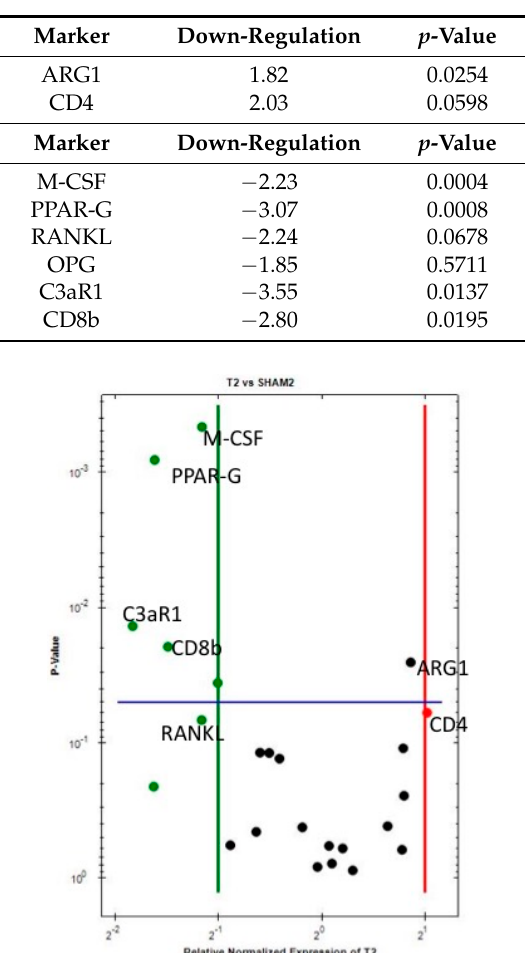
Table 3. Gene expression Ti vs. Sham.